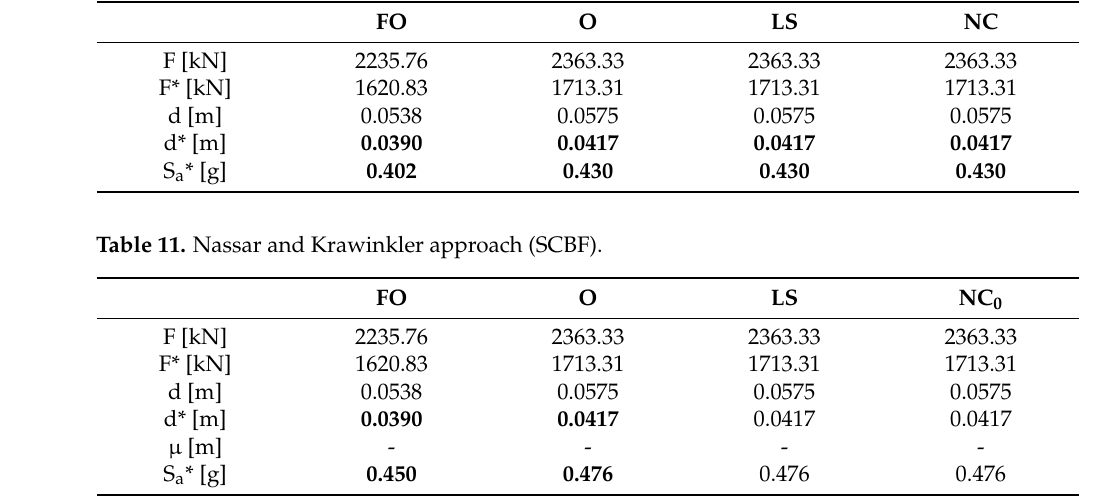
Table 10. ADRS spectrum approach (SCBF).